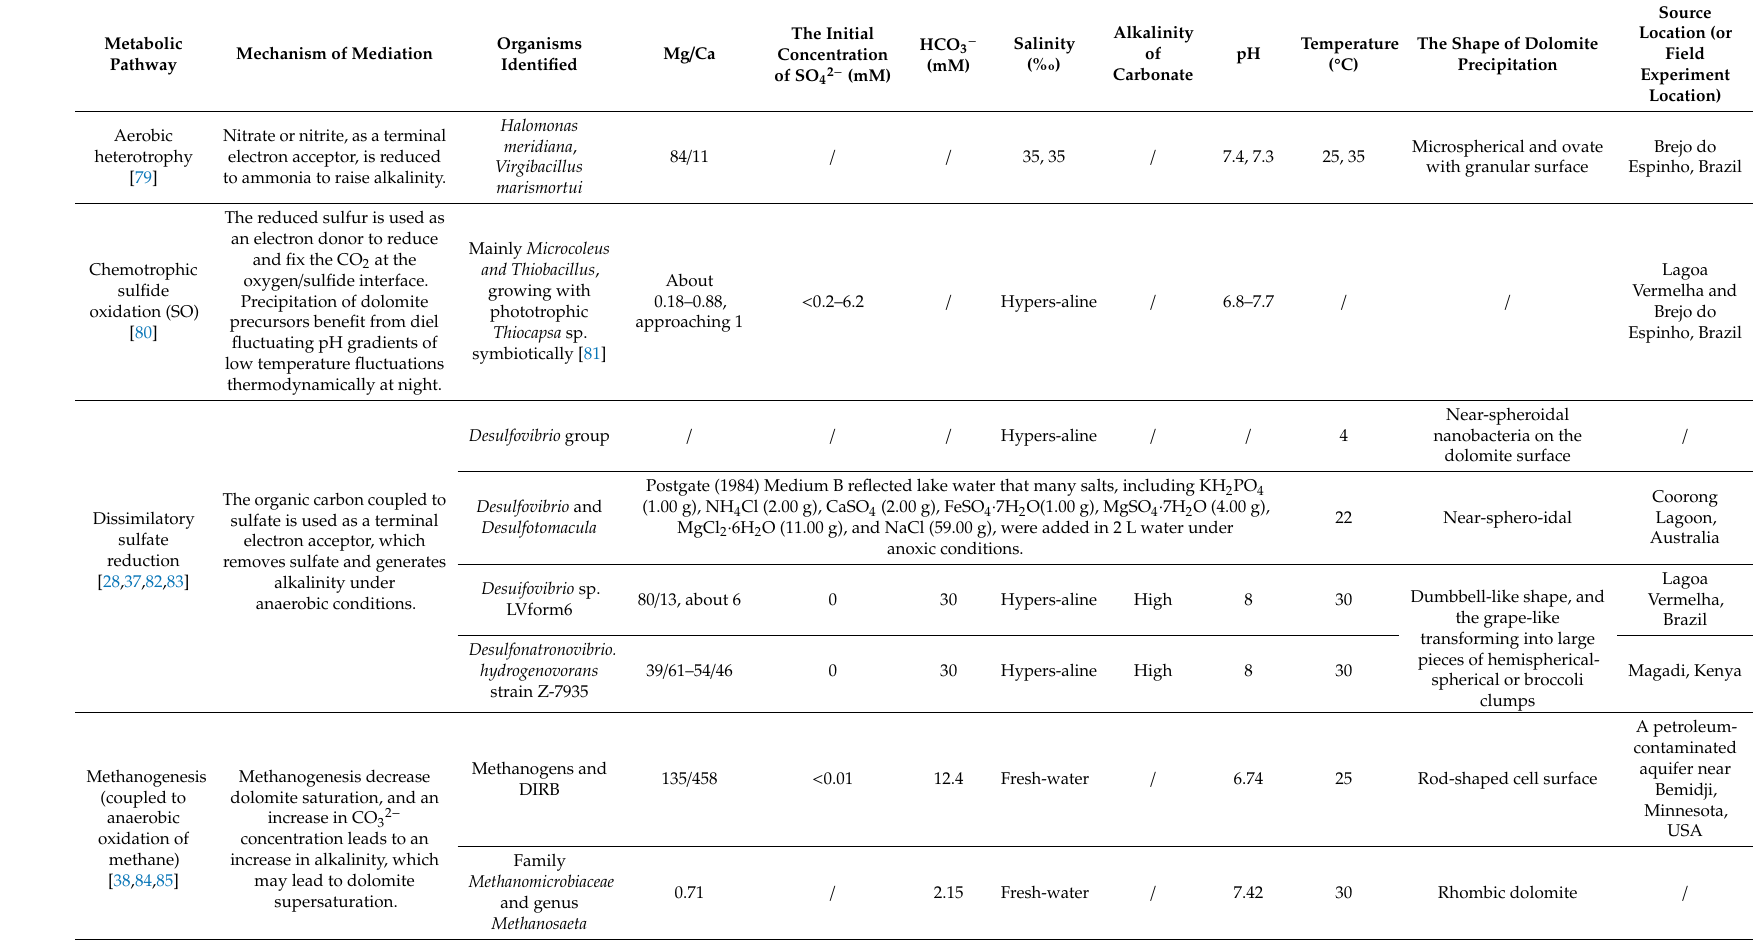
Table 1. Microbial metabolism associated with dolomite formation